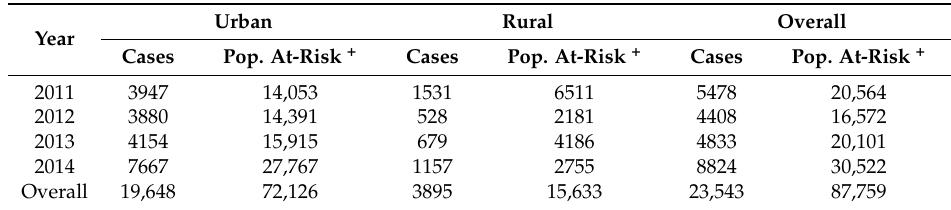
Table 4. Number of diarrhoeal cases and population at-risk among children under the age of five years per year extracted for the study period 2011–2014.